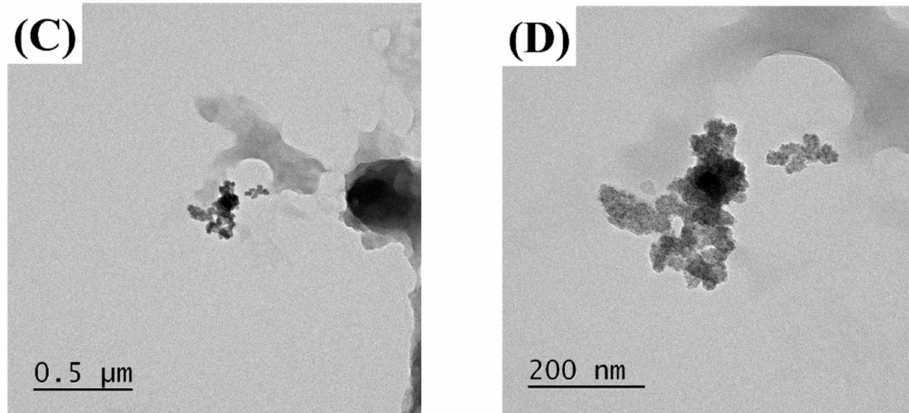
Figure 3. Transmission electron microscopy images of MUL and HME-DDS. ( A , B ), MUL powder (MUL), (500 nm, 200 nm), ( C , D ) MUL-HME-F2 (500 nm, 200 nm).